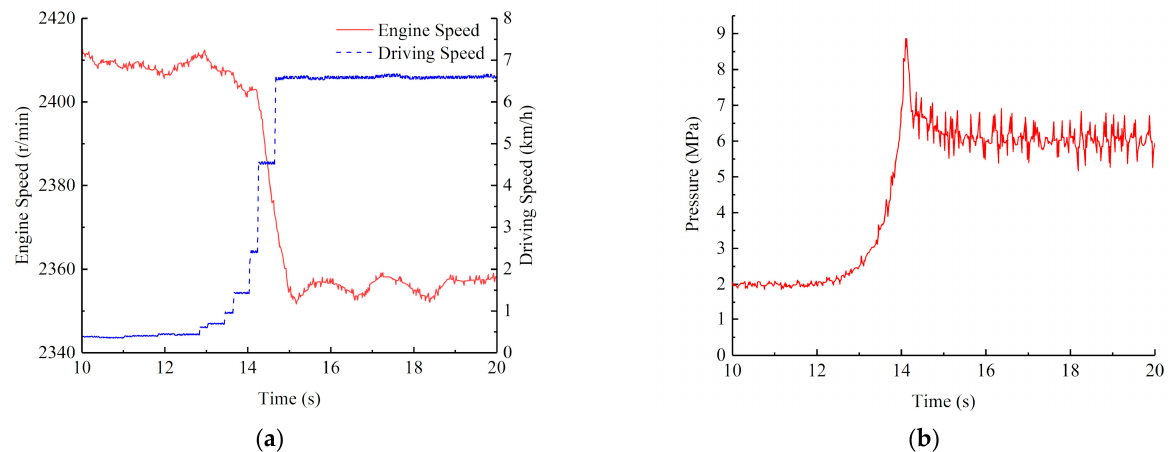
Figure 11. Parameters when starting on flat ground in Gear II: ( a ) change of the engine speed and driving speed; ( b ) change of the inlet and outlet pressure difference of the motor.